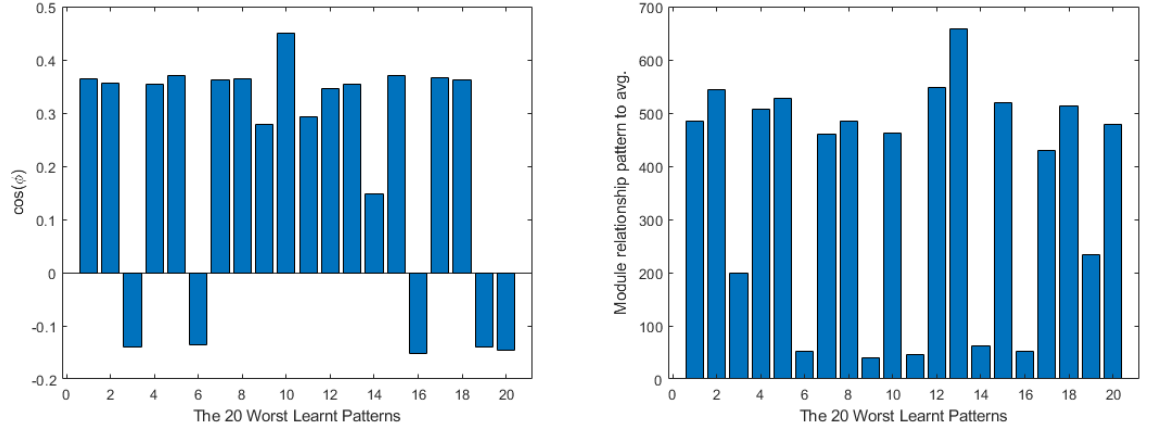
(cid:12) (cid:12) 𝜕𝐿𝑜𝑠𝑠 ∂ Loss (cid:12) (cid:12) | relationship to the average (cid:12) (cid:12) relationship to the average ∂ W n 𝜕𝑊 𝑛 𝜕𝐿𝑜𝑠𝑠 | relationship to the average 𝜕𝑊 𝑛